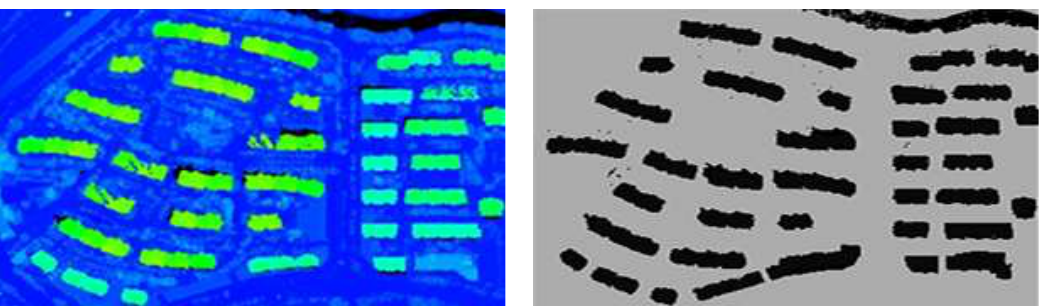
Figure 4. LDR 2 elevation coloration and manual extraction